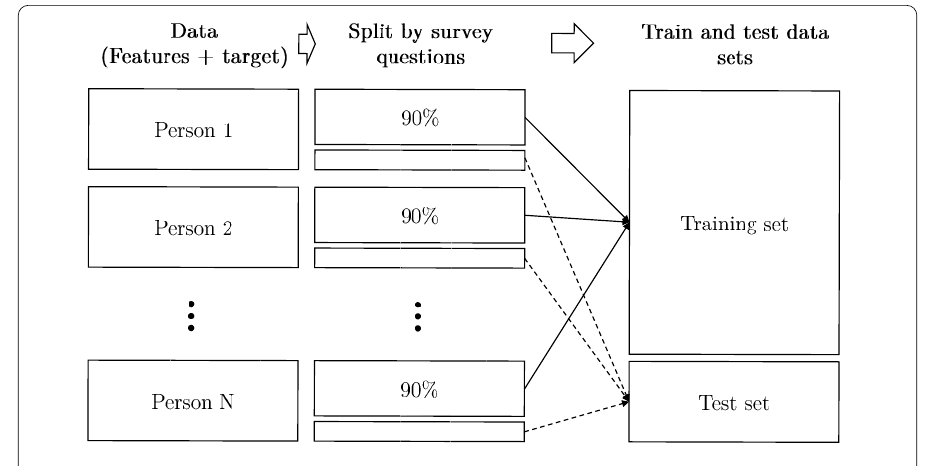
Figure 4 Illustration of Train-test Splitting for the Analysis of Predictive Validity